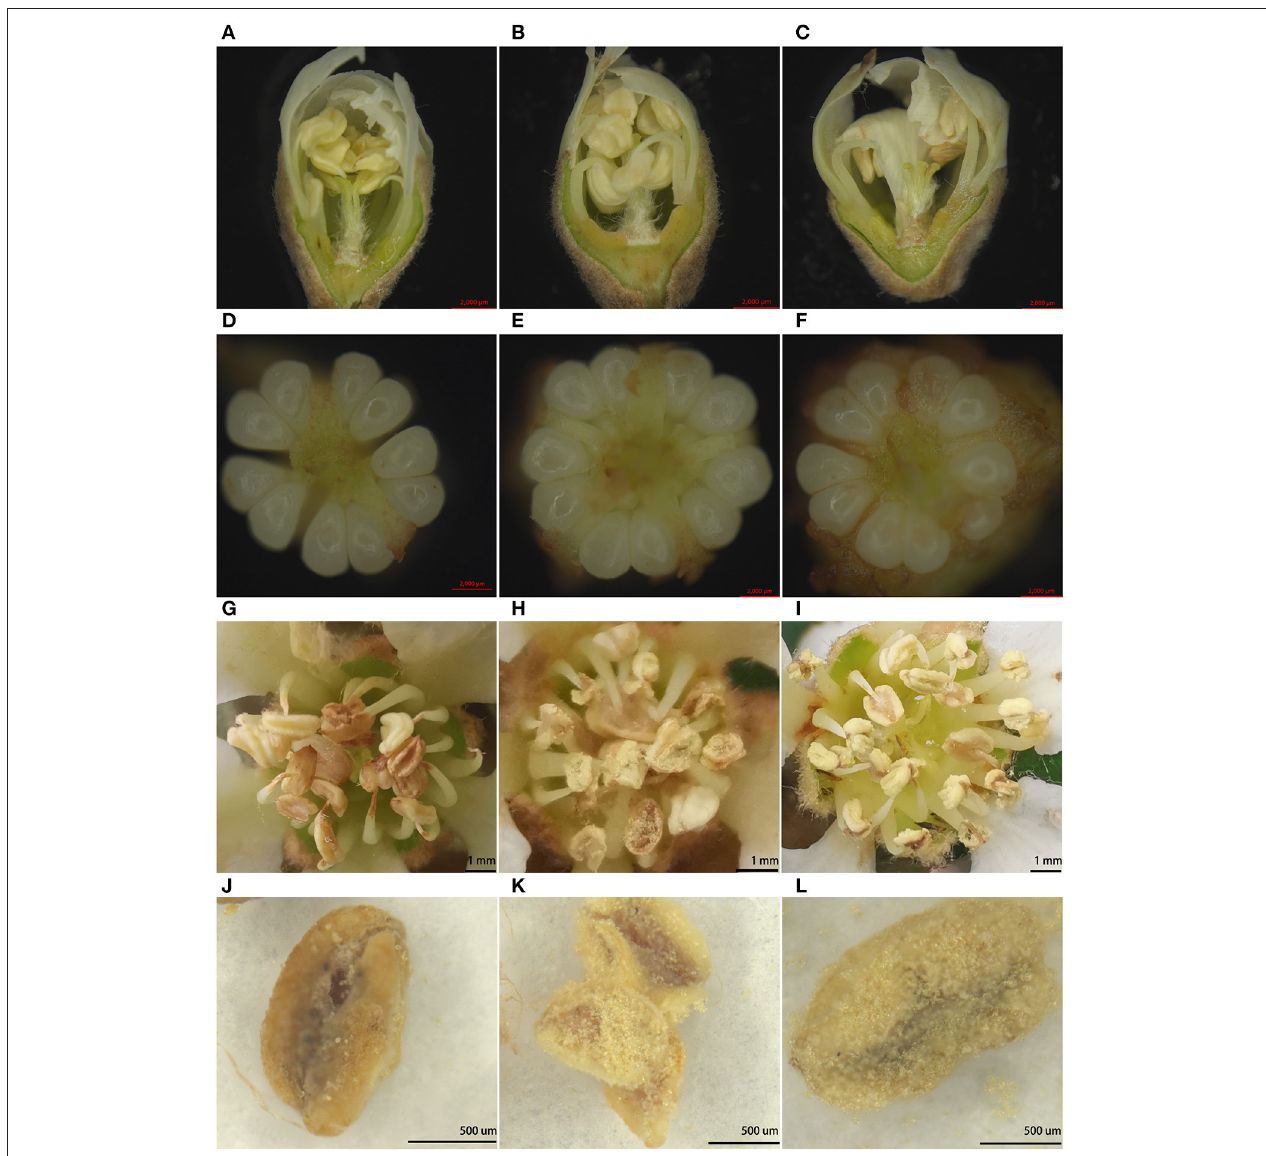
FIGURE 2 | Images of flower organs: (A–C) , vertical sections of flower buds 1 day before opening [H30-6 (A) , H411 (B) , B336 (C) ]; (D–F) , ovules in one ovary [H30-6 (D) , H411 (E) , B336 (F) ]; (G–I) , field observations of anther dehiscence [H30-6 (G) , H411 (H) , B336 (I) ]; (J,K) , dried anthers imaged under a Carl Zeiss Jena Axio Zoom. v16 microscope [H30-6 (J) , H411 (K) , B336 (L)